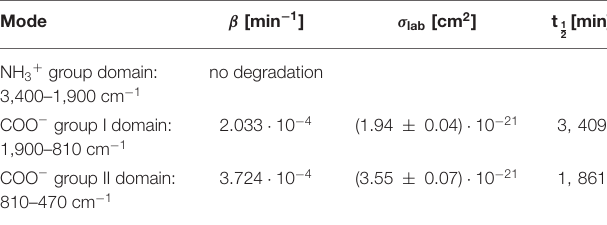
TABLE 4 | Best-fit values for the degradation rate β , cross section σ lab , and half-life time t 1 / 2lab for pure GLY irradiated in laboratory conditions. Mode β [min − 1